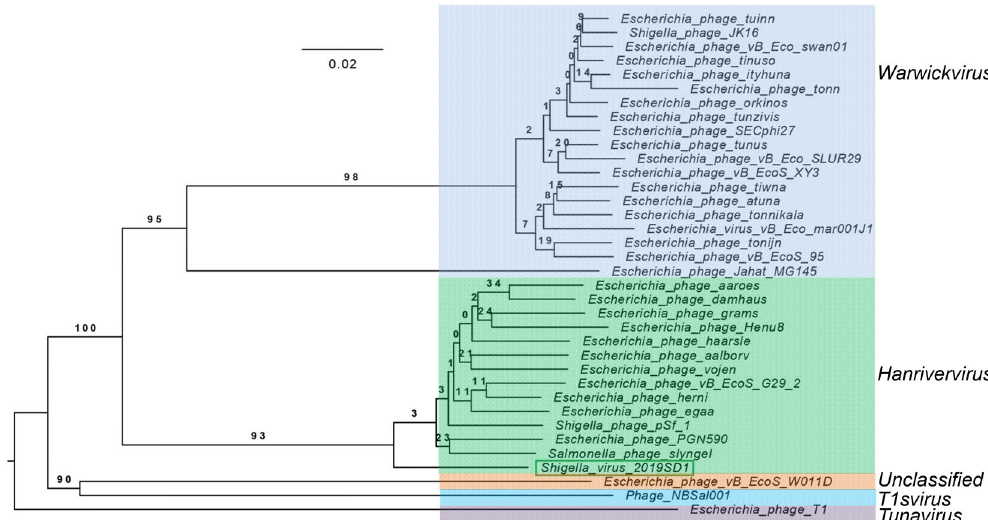
Figure 5. Comparison of the whole genome of Shigella virus 2019SD1 with 34 other members of Drexlerviridae using Phylogenomic Genome-BLAST Distance Phylogeny (GBDP) tree with prokaryotic viruses as default setting. Tree was generated using